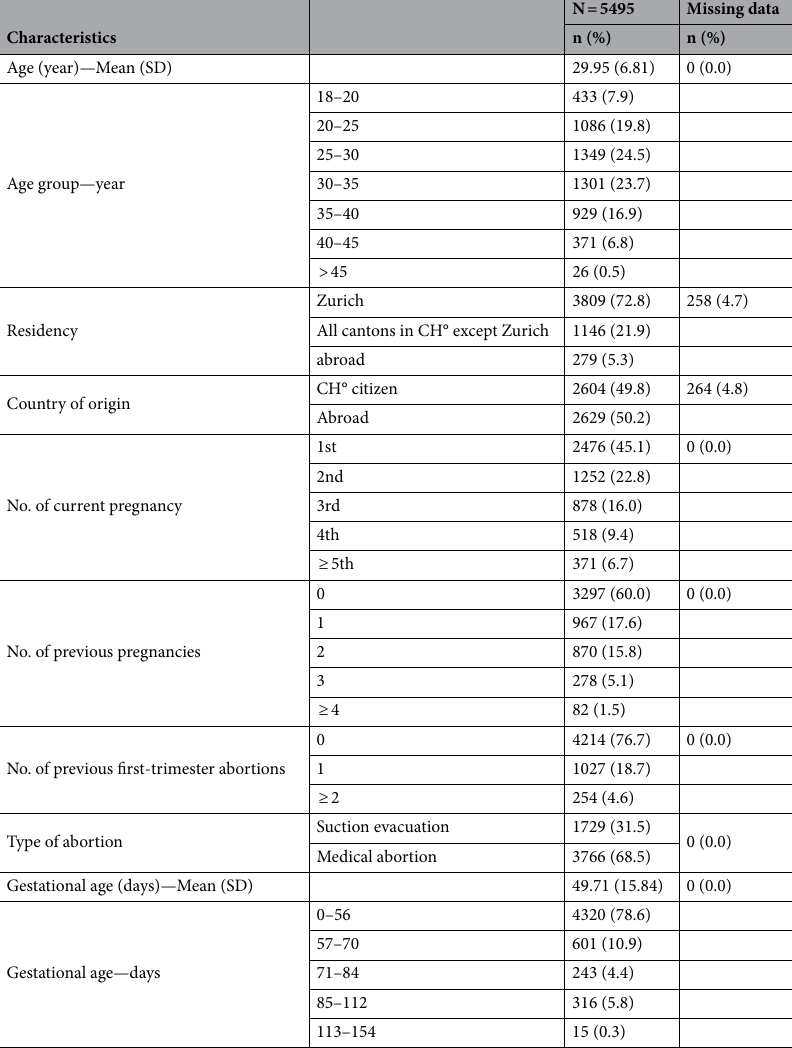
Table 3. Characteristics of the patients treated by six general practitioners (GPs) between January 2008 and December 2018 in Zurich, Switzerland. CH Switzerland.